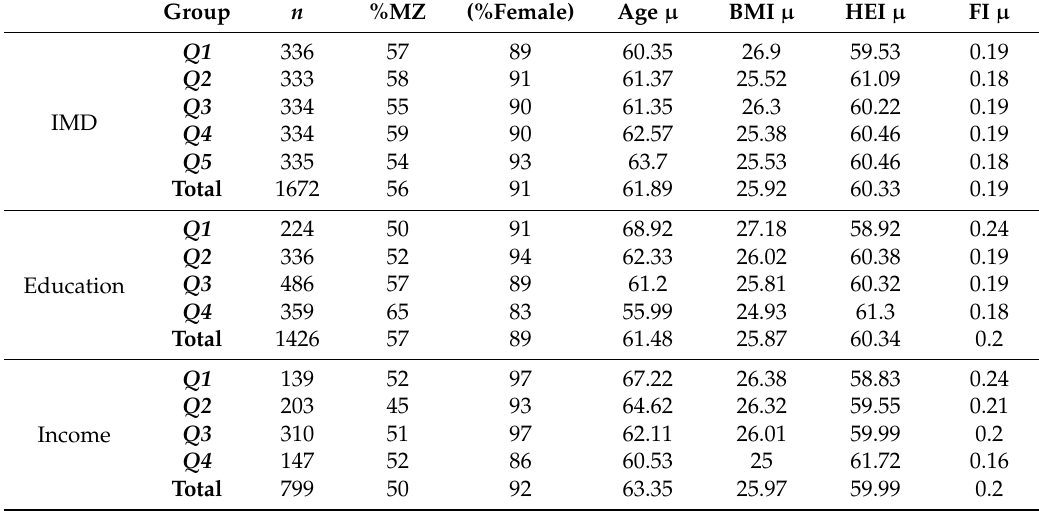
Table 1. Descriptive statistics by socioeconomic